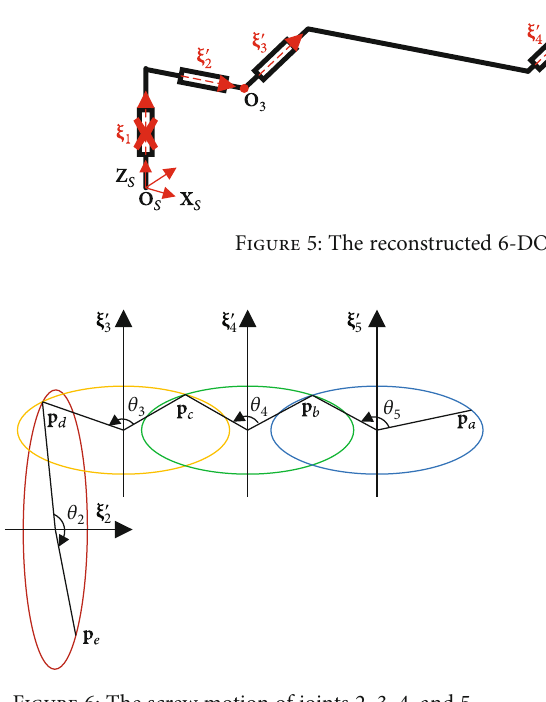
Figure 6: The screw motion of joints 2, 3, 4, and